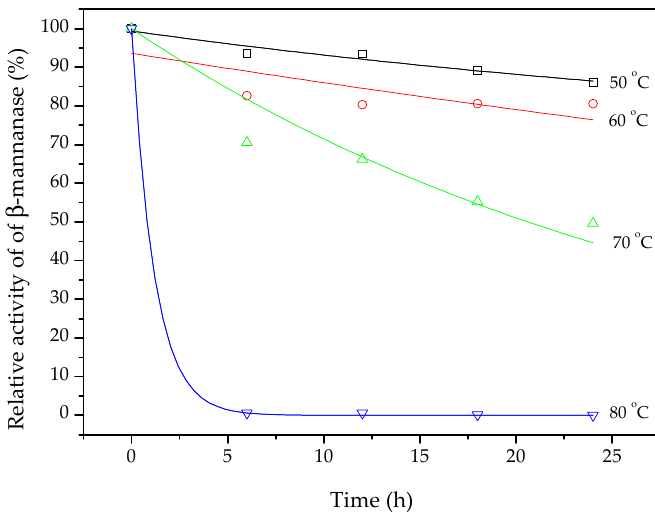
Figure 4. Thermostability of β -mannanase during 24 h at 50, 60, 70, and 80 °C. The symbols are the experimental data and the lines are exponential decay curve fits.